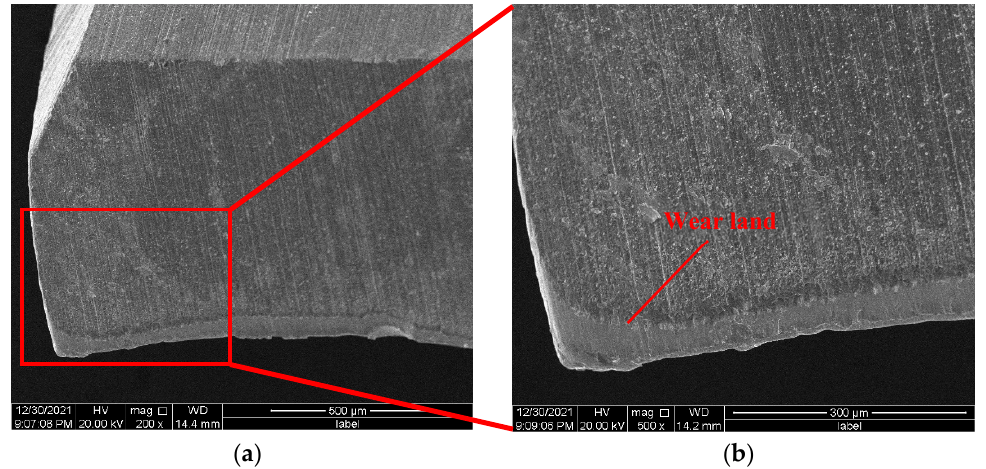
Figure 8. Wear appearance of the AlTiN-coated drill. ( a ) 200 × enlarged view (after drilling 55 holes). ( b ) 500 × enlarged view (after drilling 55 holes).